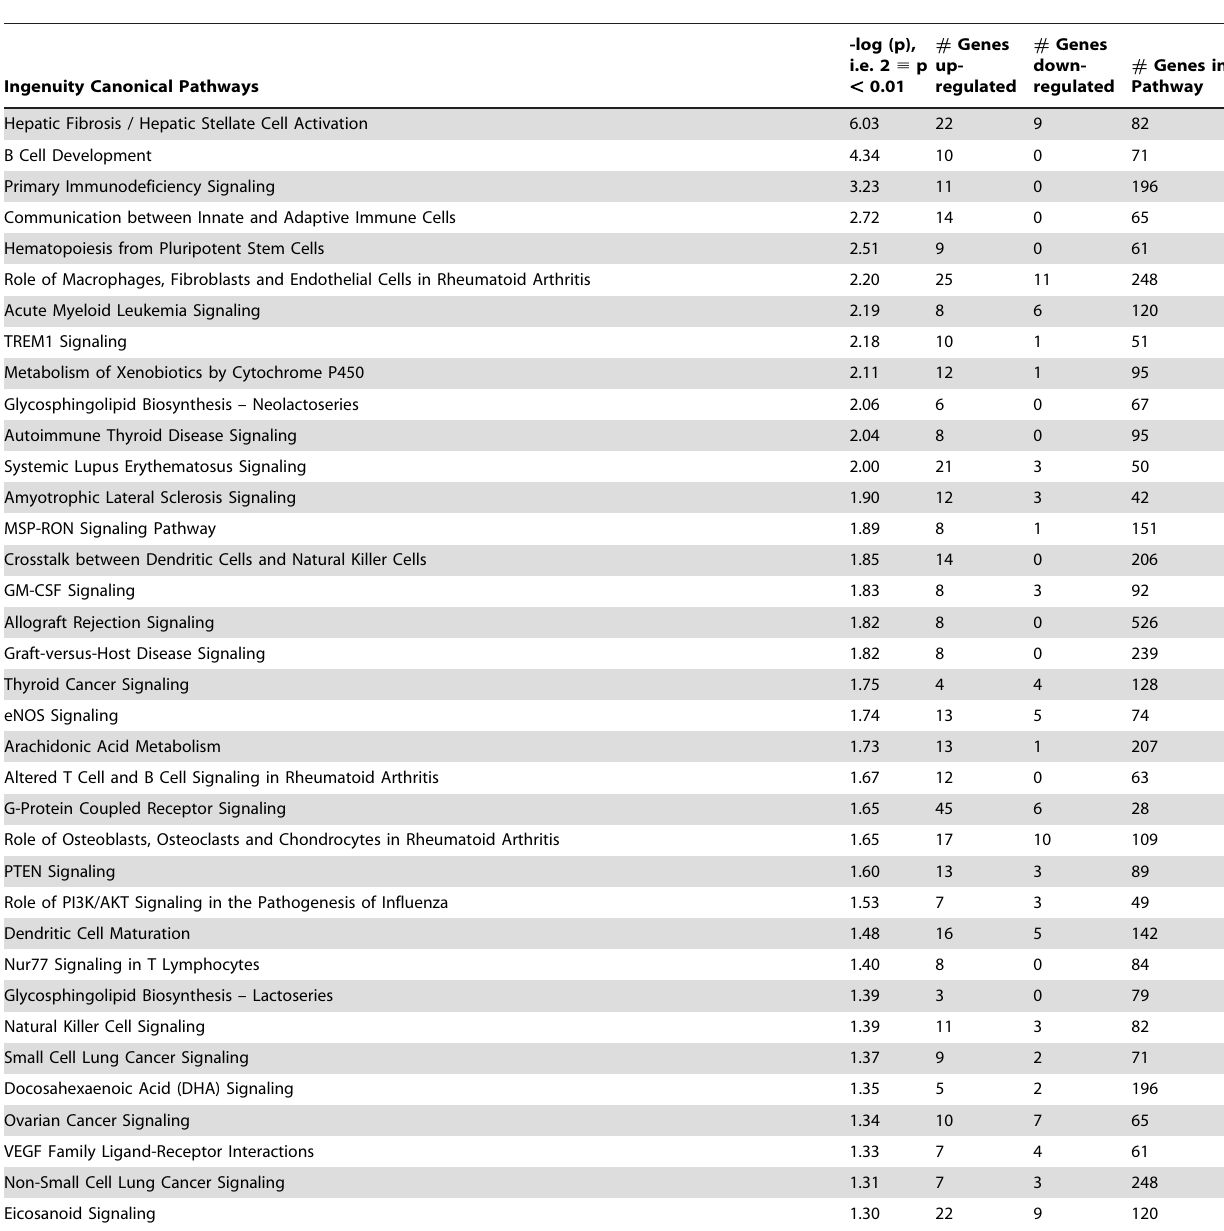
Table 1. Canonical pathways significantly enriched (P , 0.01) in endometrial tissue of women with endometrial C. trachomatis infection vs. endometrial tissue of women with no existing upper or lower genital tract infection.